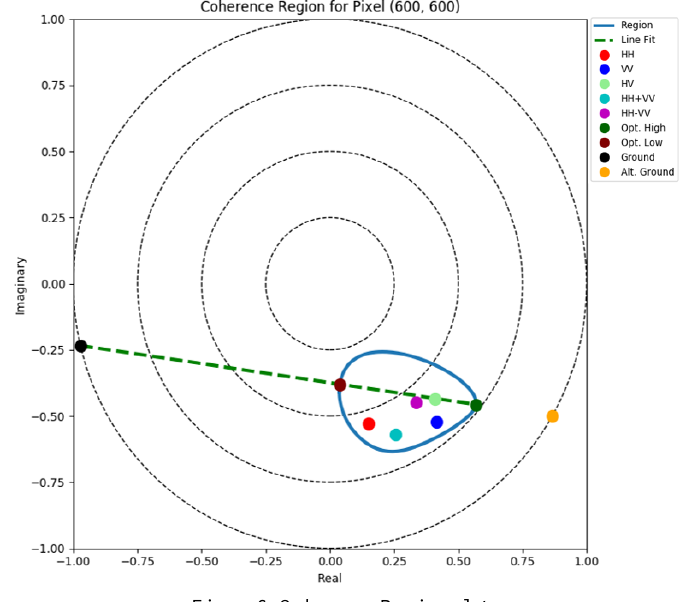
Figure 6. Coherence Region plot